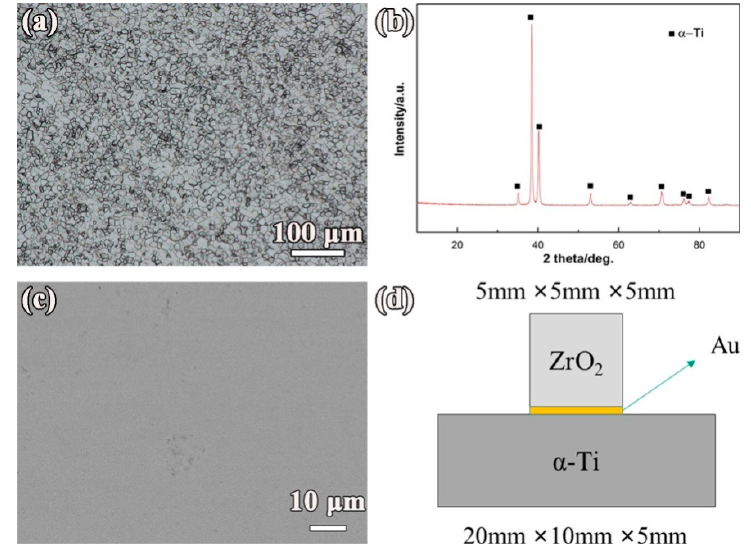
Figure 1. Microstructures of substrates and schematic diagram of brazing assembly. ( a ) Metallographic figure of α -Ti alloy, ( b ) XRD pattern of α -Ti alloy, ( c ) BSE image of ZrO 2 ceramic and ( d ) brazing assembly.